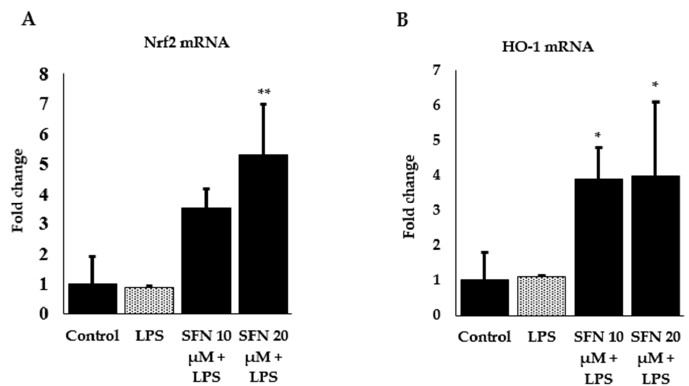
Figure 5. E ff ect of SFN on upregulation of transcription factor Nrf2 ( A ) and phase 2 enzyme HO-1 ( B ) in LPS-stimulated cells. Raw 264.7 cells were incubated with SFN (10 and 20 µ M) for 6 h, then incubated with LPS in both SFN pre-treated and untreated cells for 24 h. Total RNA was extracted and prepared for mRNA gene expression of Nrf2 and HO-1 by RT-qPCR. Fold changes are presented after normalization to the internal control β -actin . The results are expressed as mean ± SE (** p < 0.01, * p < 0.05 as compared to LPS